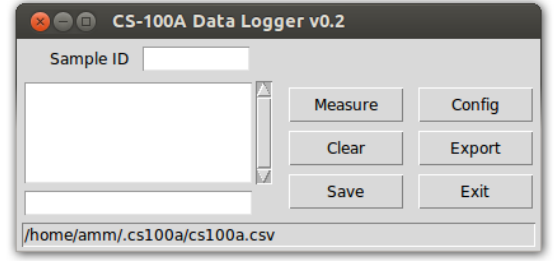
Figure 6: Main window of the program